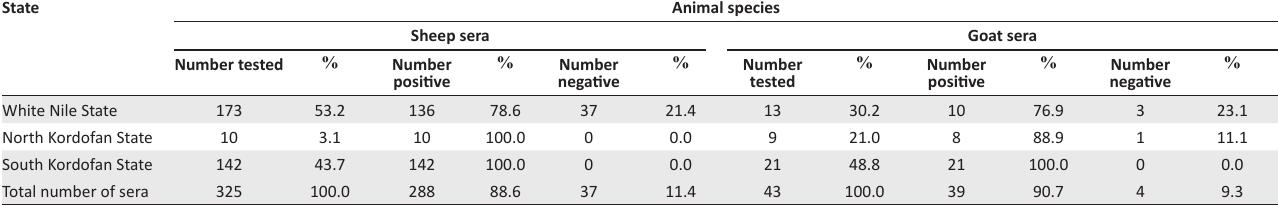
TABLE 4: Seroprevalence of peste des petits ruminants virus antibodies in sheep or goat sera in surveyed States of Sudan.